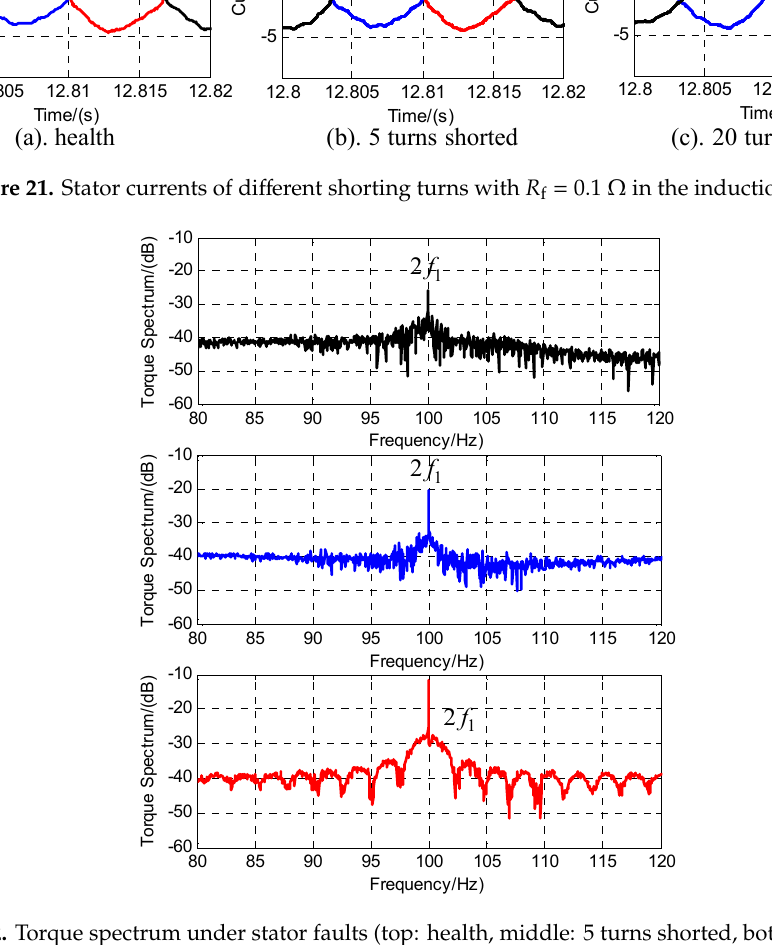
Figure 22. Torque spectrum under stator faults (top: health, middle: 5 turns shorted, bottom: 20 turns shorted).